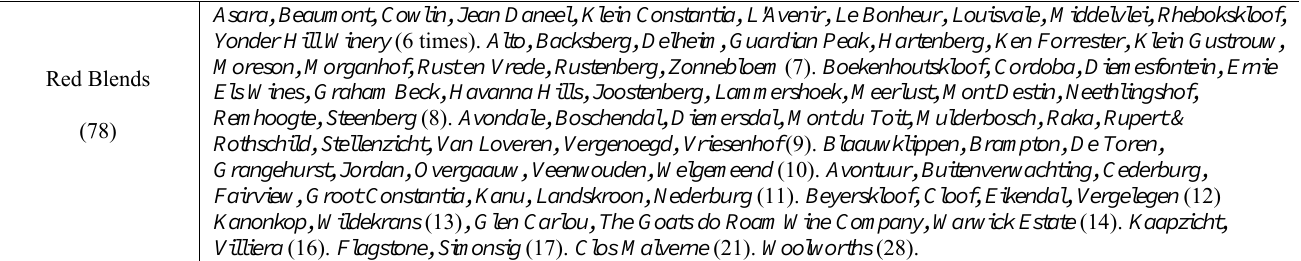
Table 5: Candidate brands (172 in all) as they appear in each of white wine varietal subsets. Citing frequency appears in brackets. WHITE CULTIVARS : CANDIDATE BRANDS INCLUDED IN ANALYSIS brands